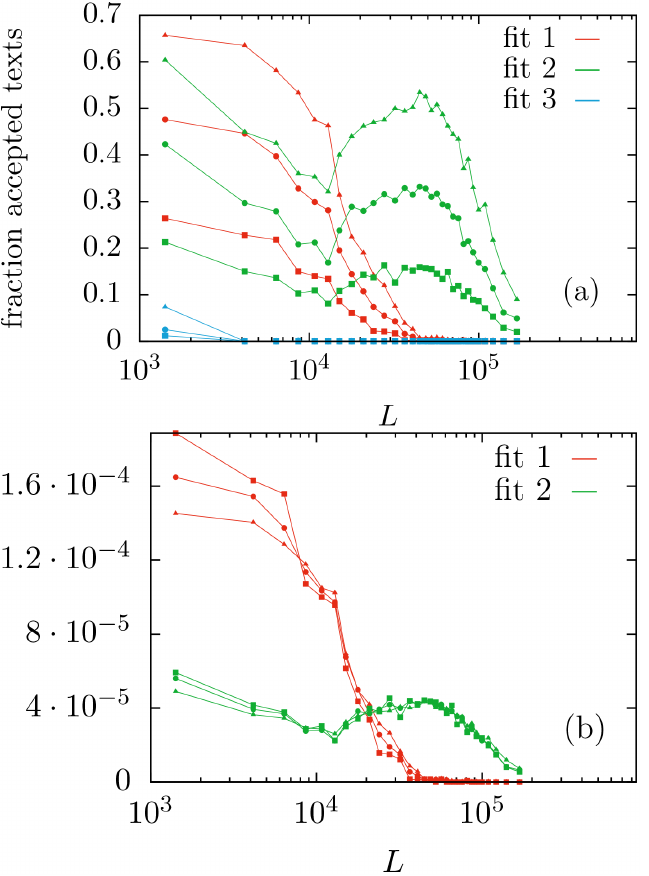
Fig 7. (a) Histograms showing the fraction of accepted texts by the three distributions as a function of their text length, for three different significance levels p 0 : 0.05 (upper curves), 0.20 (middle), 0.50 (lower). To be concrete, for each range of L , the ratio between the number of texts with p (cid:2) p 0 and the number of texts in that range is calculated. (b) Same curves (removing those for distribution 3) under rescaling. We rescale the y — axis by the number of p (cid:2) p 0 , in each case, showing that the relative performance of each fit with regard L is independent on the significance level. Bins are selected to contain 1000 texts each.